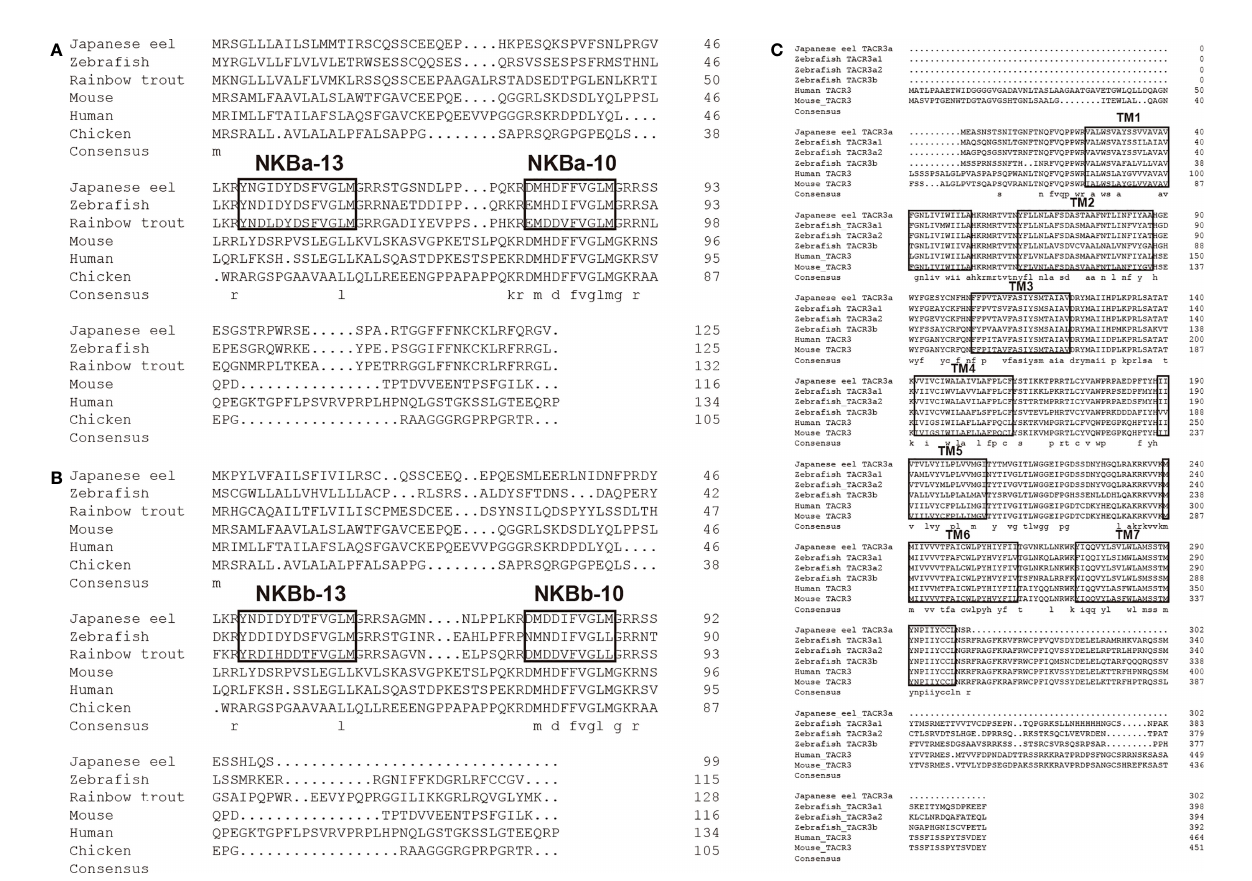
FIGURE 2 | Comparison of the amino acid sequences of Japanese eel tac3a (A) and tac3b (B) precursors from different species. The boxed letters indicated the sequence of mature NKB peptides in the detected species. Comparison of the amino acid sequences of Japanese eel tacr3 (C) precursors from different species. The boxed letters indicated the sequence of transmembrane domains in the detected